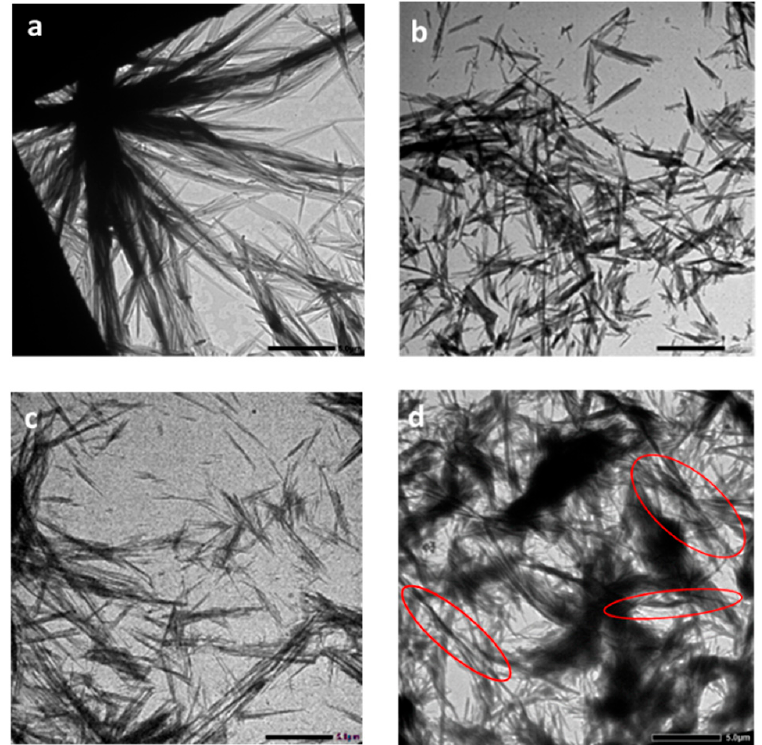
Figure 4. TEM images: ( a ) 0.05 wt% DIBA in octane (solution/sol); ( b ) 2 wt% DIBA in octane (gel); ( c ) 2 wt% DIPA in octane (gel); and ( d ) 0.5 wt% DIBA in hexylbenzene (solution/sol). The scale bar represents 5 µ m. The red circles in image ( d ) emphasize regions where twisting is obvious.